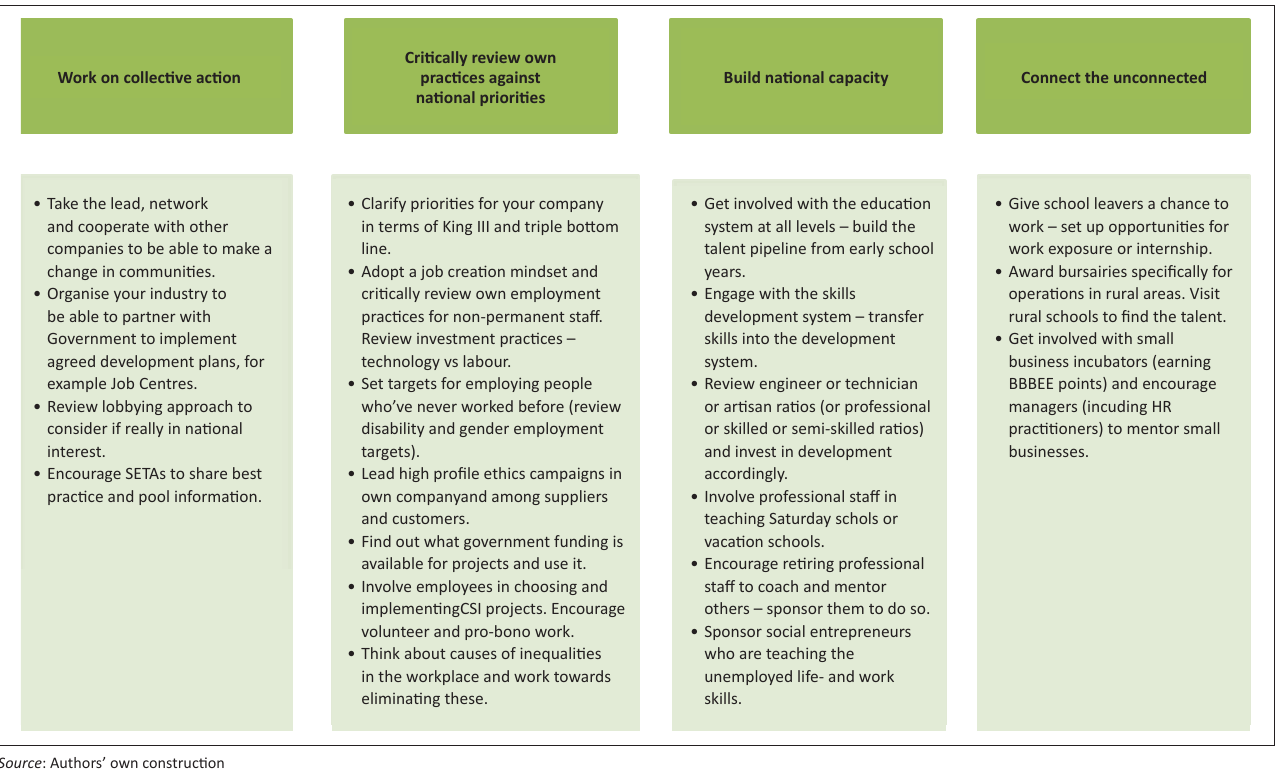
FIGURE 6: Possible elements of a response at a strategic level in an organisation.